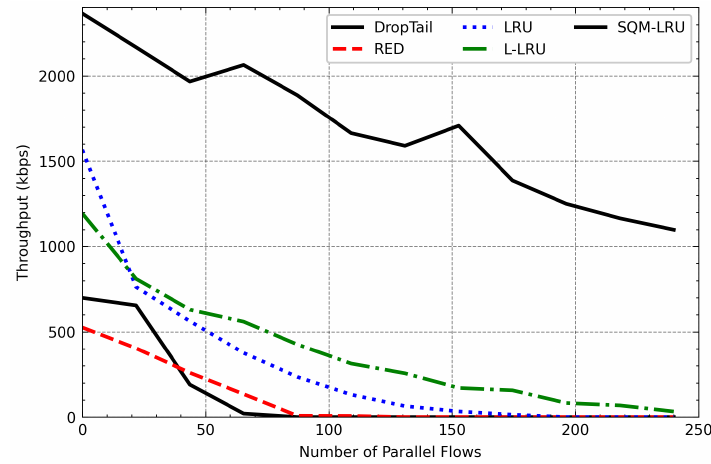
Figure 14. FTP throughput varies with the number of parallel flows.